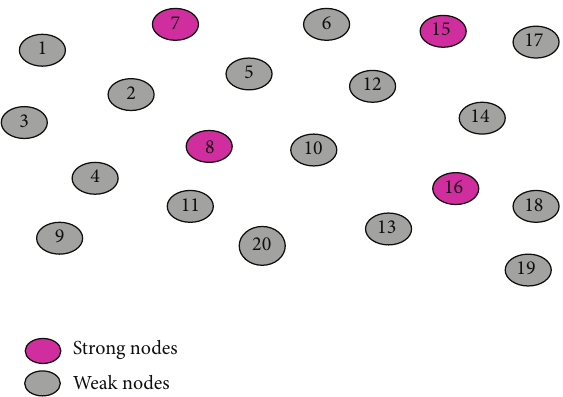
Figure 1: Selection of strong and weak